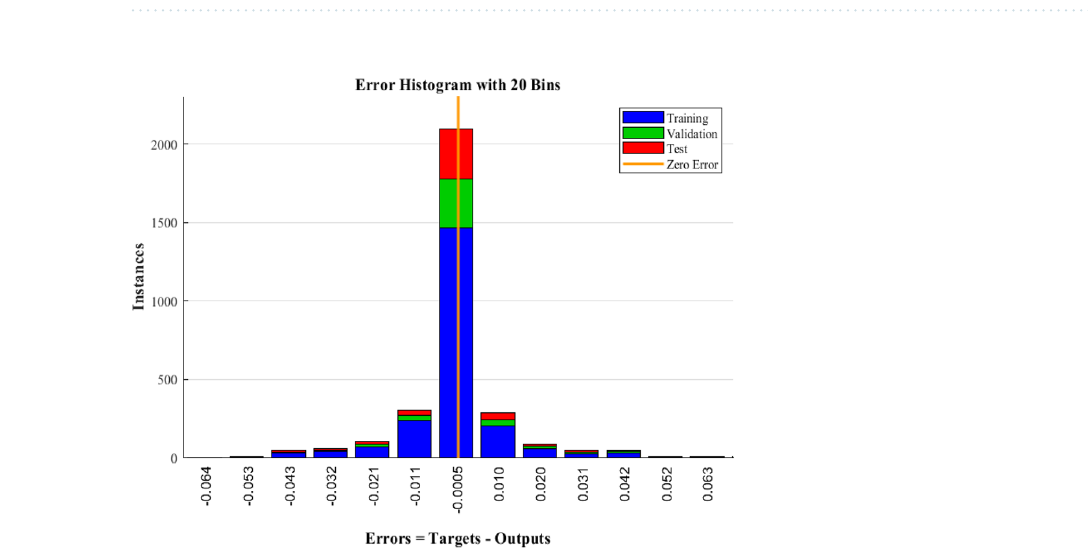
Table 4. Training and testing results for ANN model.